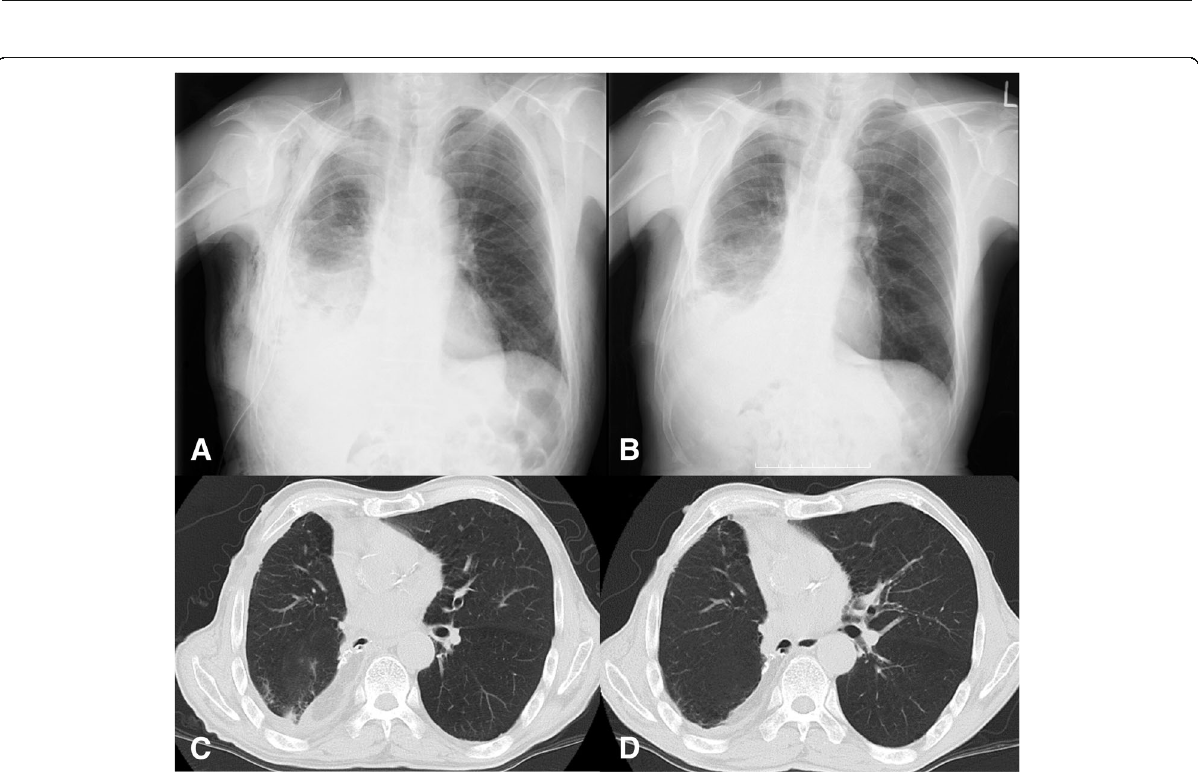
Fig. 3 Findings after reoperation. After re-operation, the chest X-ray images on POD 2 ( a ) and POD 14 ( b ), as well as the chest CT images at 1 month ( c ) and at 3 months ( d ), are shown. CT computed tomography, POD postoperative